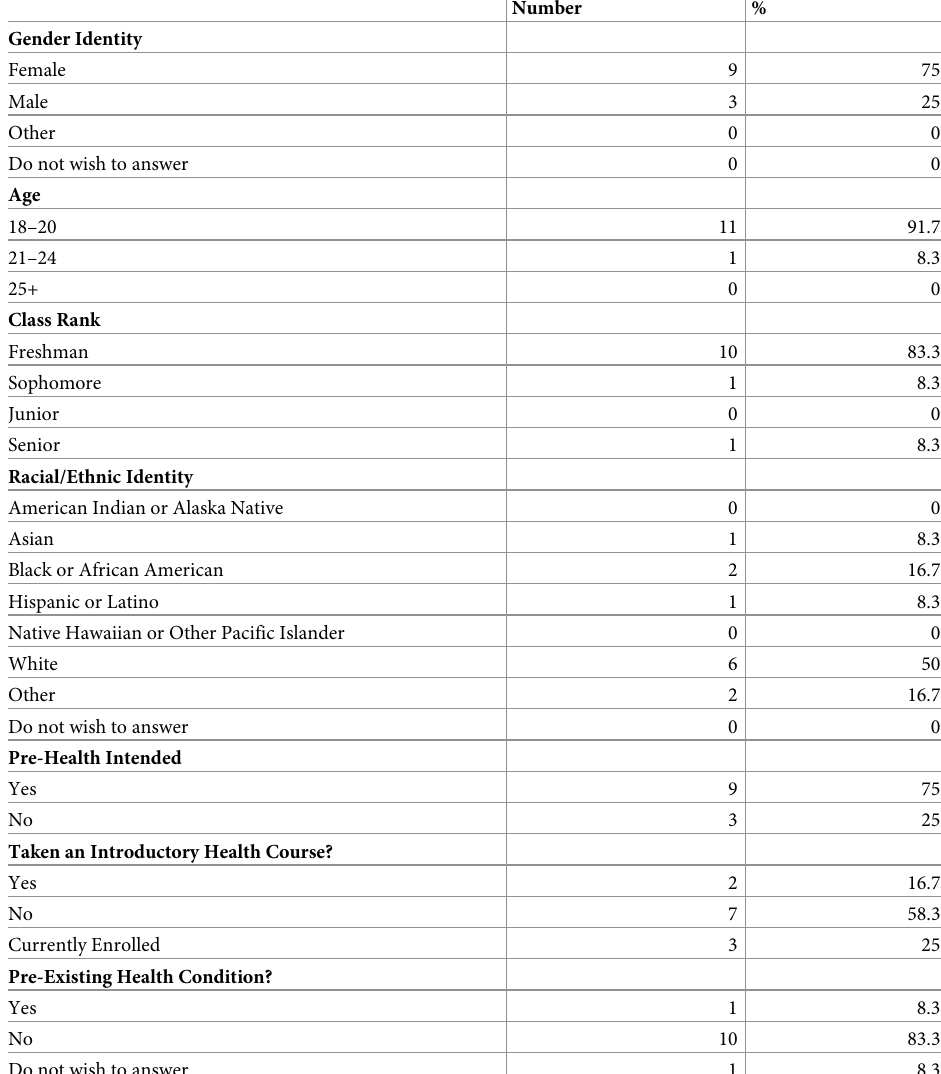
Table 5. Demographic characteristics of individuals participating in an interview (N =